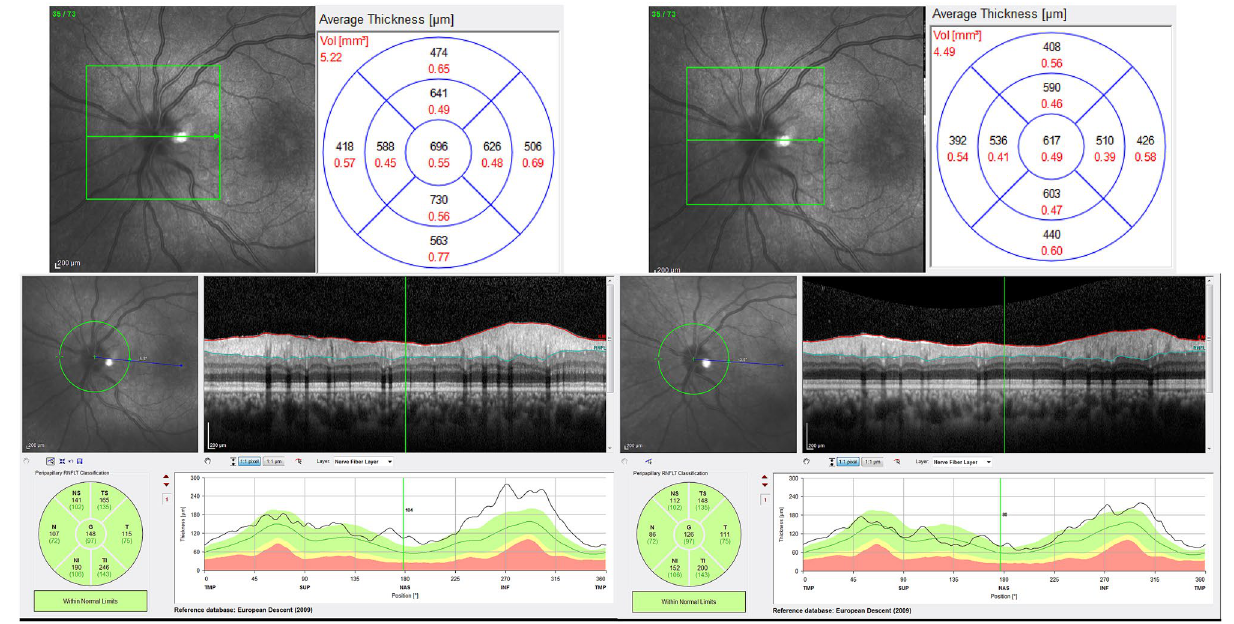
Figure 4. Representative baseline and follow up peripapillary imaging: peripapillary retinal thickness (top) and peripapillary retinal nerve fiber layer thickness (bottom) measurements of the left eye of one of our patients with Behcet’s retinal vasculitis at baseline (left side), and 10.5 months later (right side) show that thickness values approach normal with treatment at 10.5 months follow up